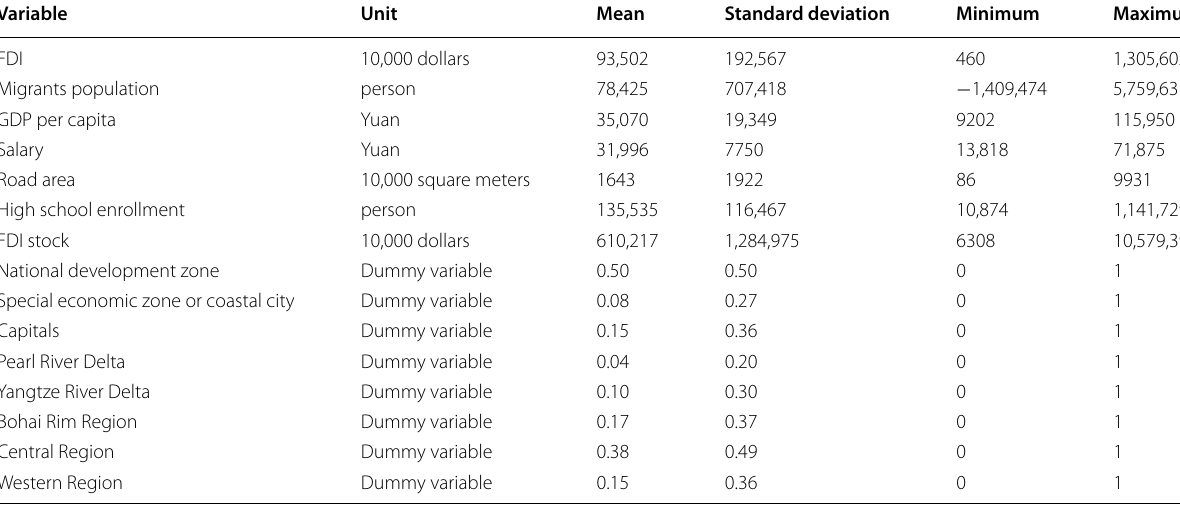
Table 2 Summary statistics of variables